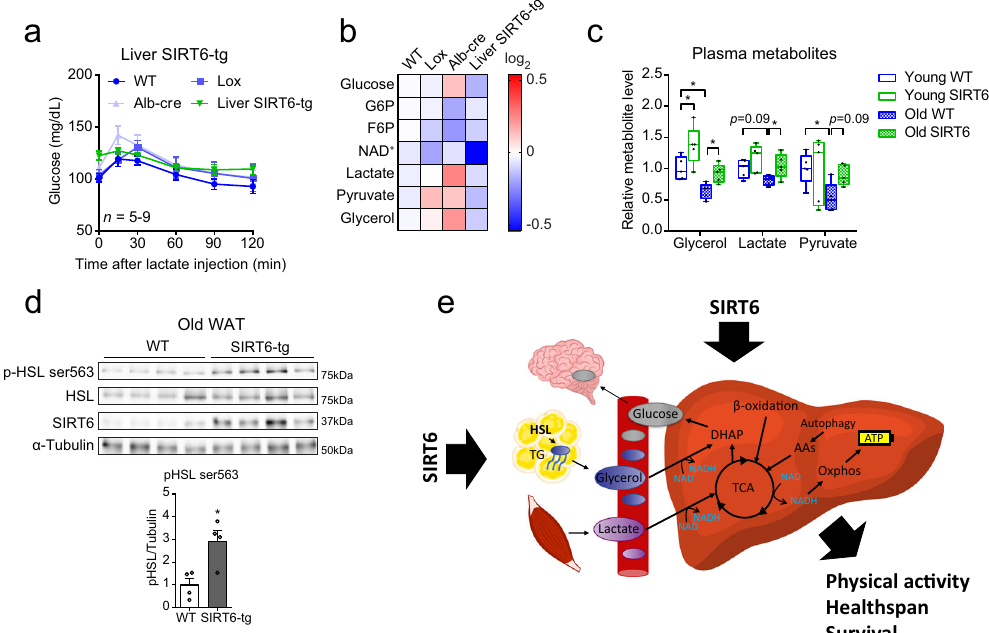
Fig. 7 Enhanced adipose tissue-derived glycerol contributes to maintenance of normoglycemia in aged SIRT6-tg mice. a Lactate tolerance test in 22 – 24 months old liver-speci fi c SIRT6-tg and appropriate littermate control male mice. Values are mean ± SEM of n = 6 WT mice, n = 5 lox mice, n = 9 Alb-cre mice and n = 5 liver SIRT6-tg mice. Two-way ANOVA showed no difference between liver SIRT6-tg and controls. Bars represent mean ± SEM. b Heatmap of GNG-related hepatic metabolites in 23 – 25 months old liver SIRT6-tg male mice and control littermates. Each square represents average metabolite abundance of n = 5 mice per genotype. See Supplementary Table 9 for source data. c Levels of the GNG precursors glycerol, lactate and pyruvate in the plasma of 6 h-fasted young (5 – 7 months) and old (20 – 24 months) mice, n = 5, males. Box extends from the 25th to 75th percentiles, line